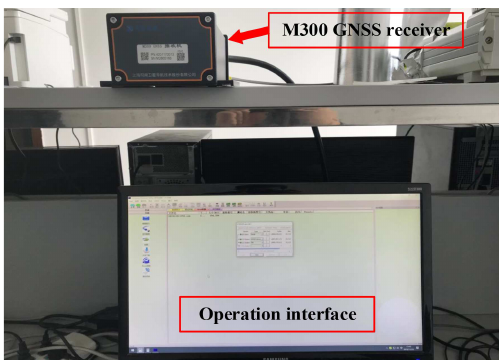
Figure 5. The Sinan M300 GNSS receiver experimental